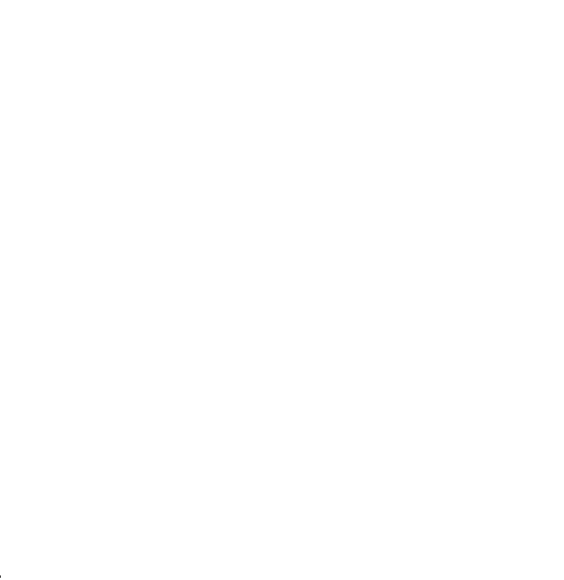
Table 8. Distance between two